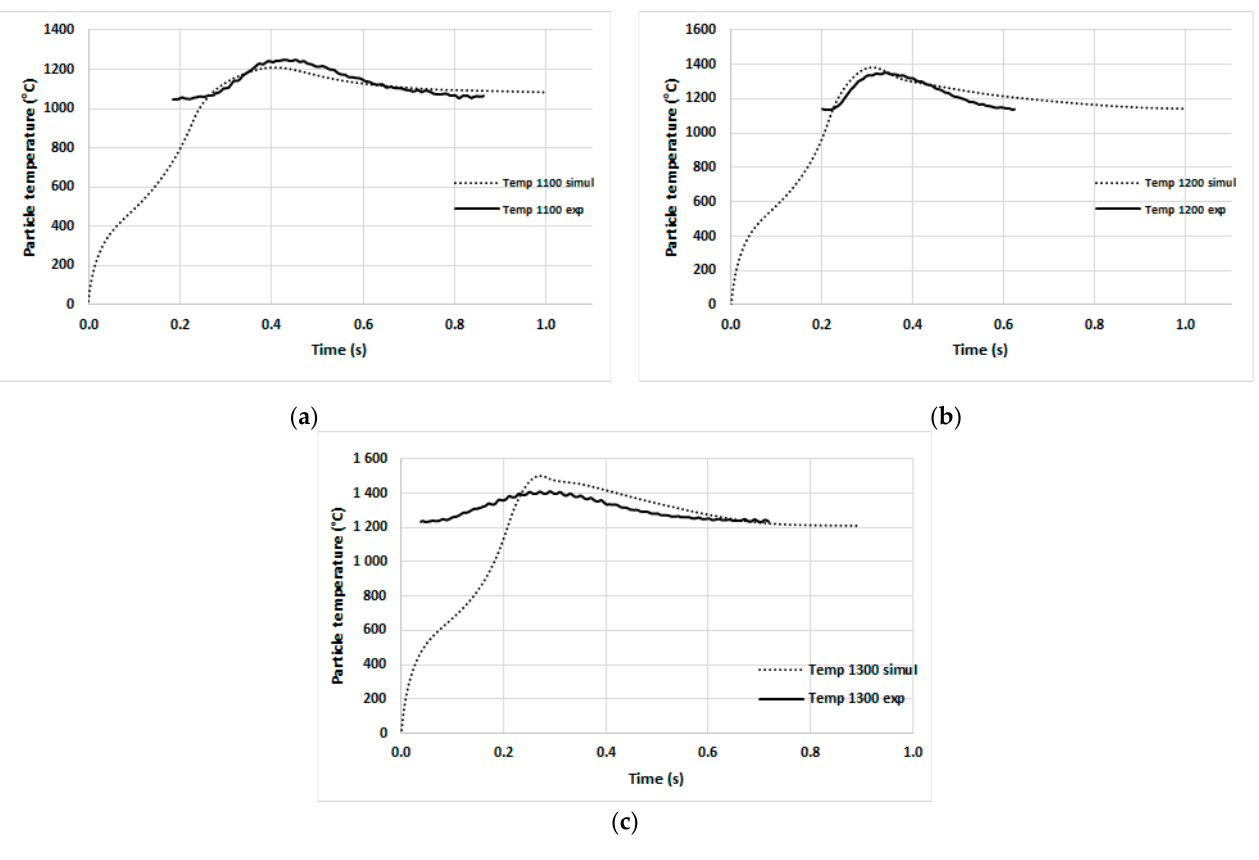
Figure 2. Experimental (solid line) and simulated (dotted line) particle temperature for the regulation temperature of the reactor equal to 1100 ( a ), 1200 ( b ) and 1300 °C ( c ).